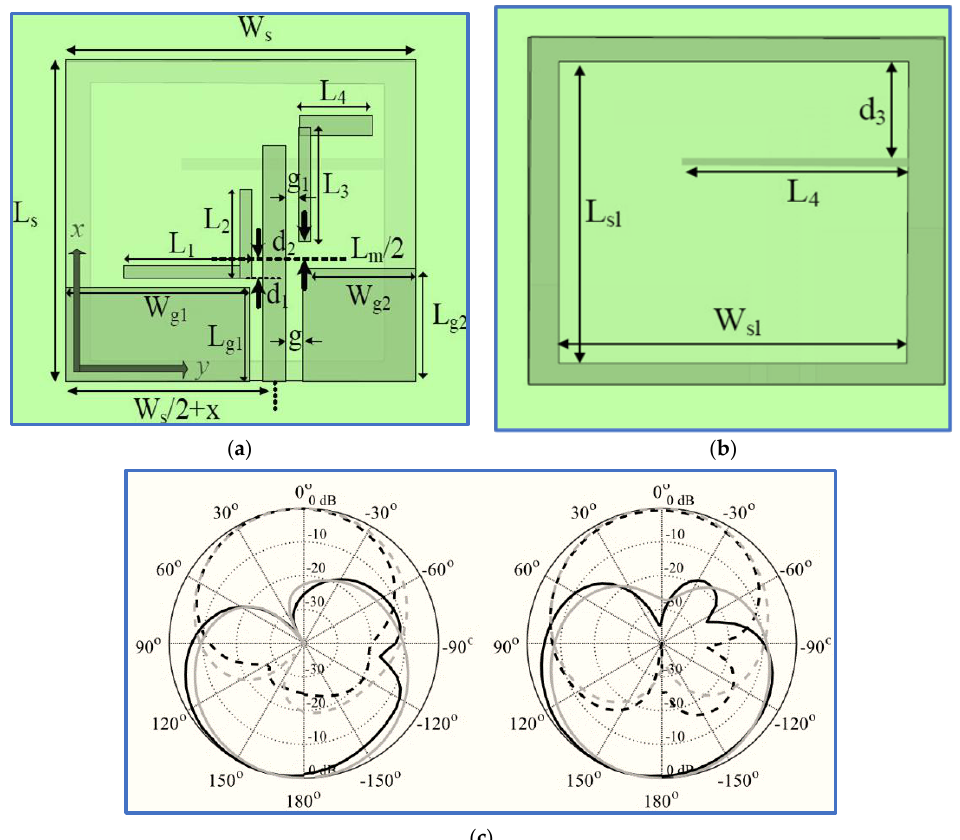
Figure 17. Geometry of a CP slot antenna with coplanar strip: ( a ) front side; ( b ) back side; ( c ) simu- lated and measured CP radiation pattern in the xz-plane RHCP and LHCP at 2.5 GHz [24].